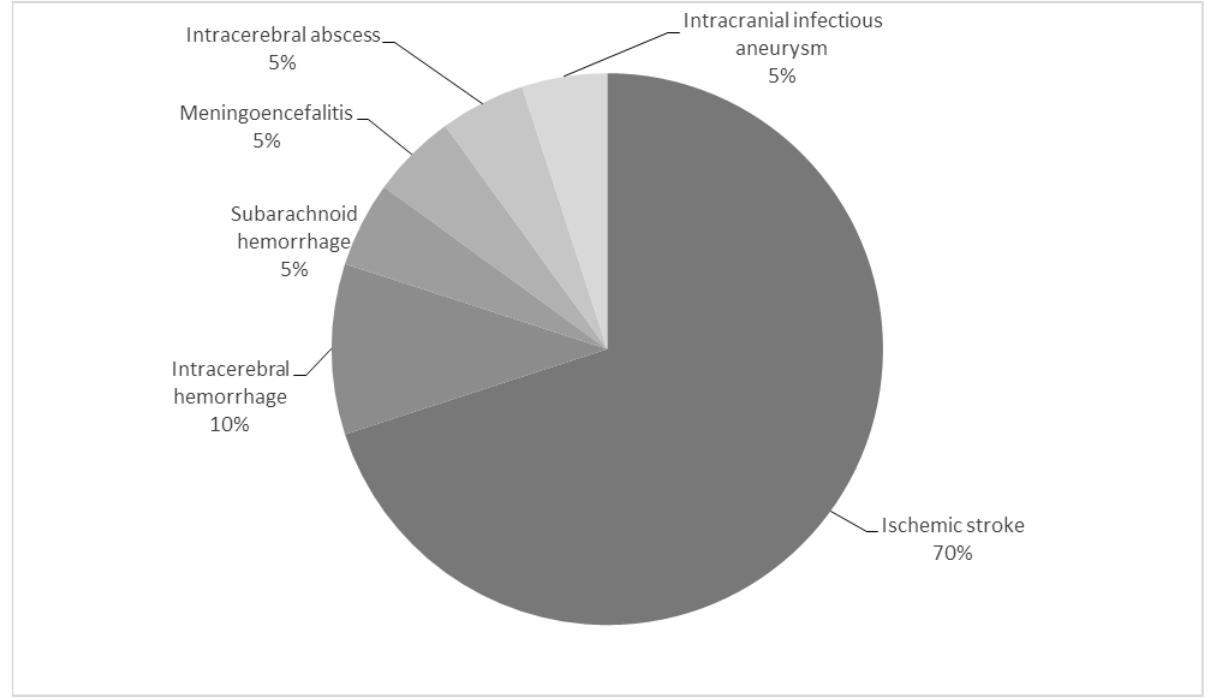
Figure 1. Neurological complication in infective endocarditis and approximate proportions. Adapted from Yanagawa B et al. [8].